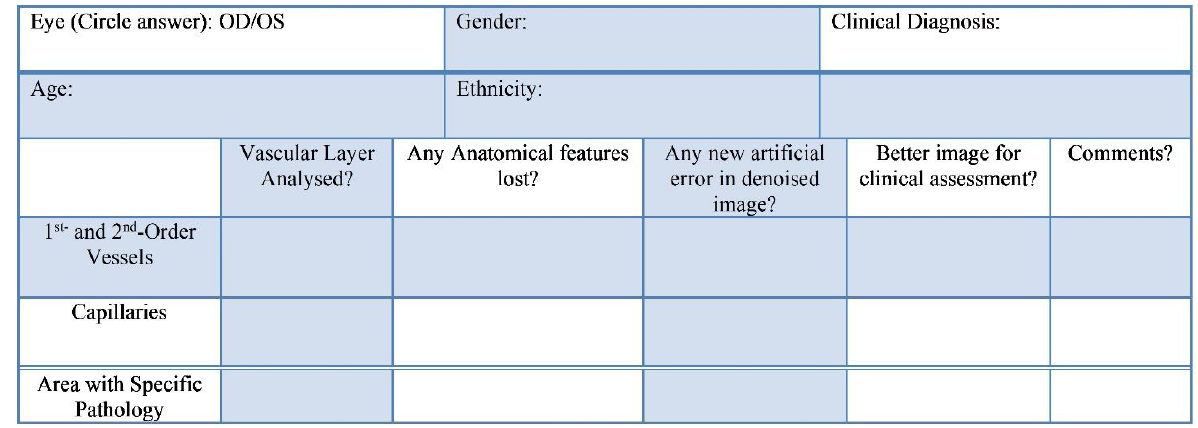
Figure A1. Deep learning denoise model schematic.